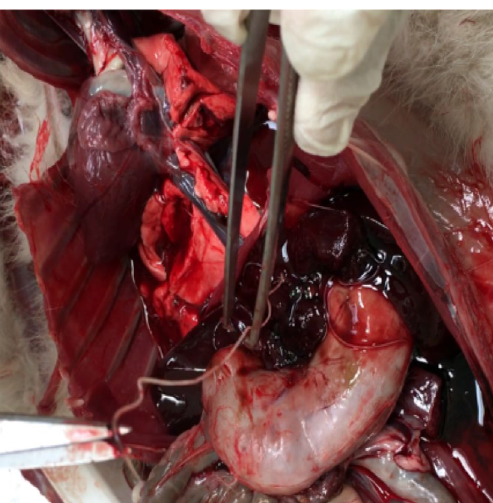
Figure 2. Necropsy from hare-1. One of the filariae observed is held by tweezers and